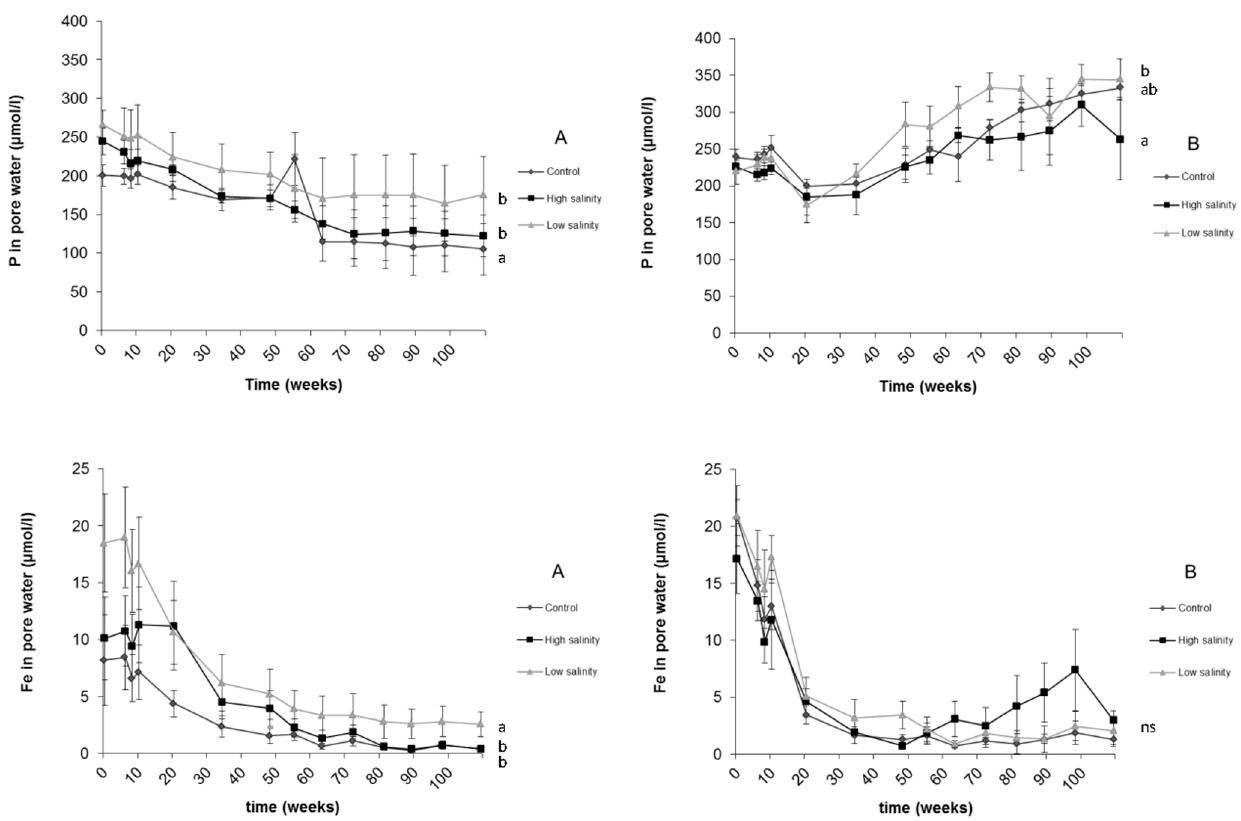
Figure 2. Phosphorus (P) and iron (Fe 2 + ) concentrations ( m mol L 2 1 ) in pore water of both sediments (A: left, B: right). Significant differences between treatments are indicated with different